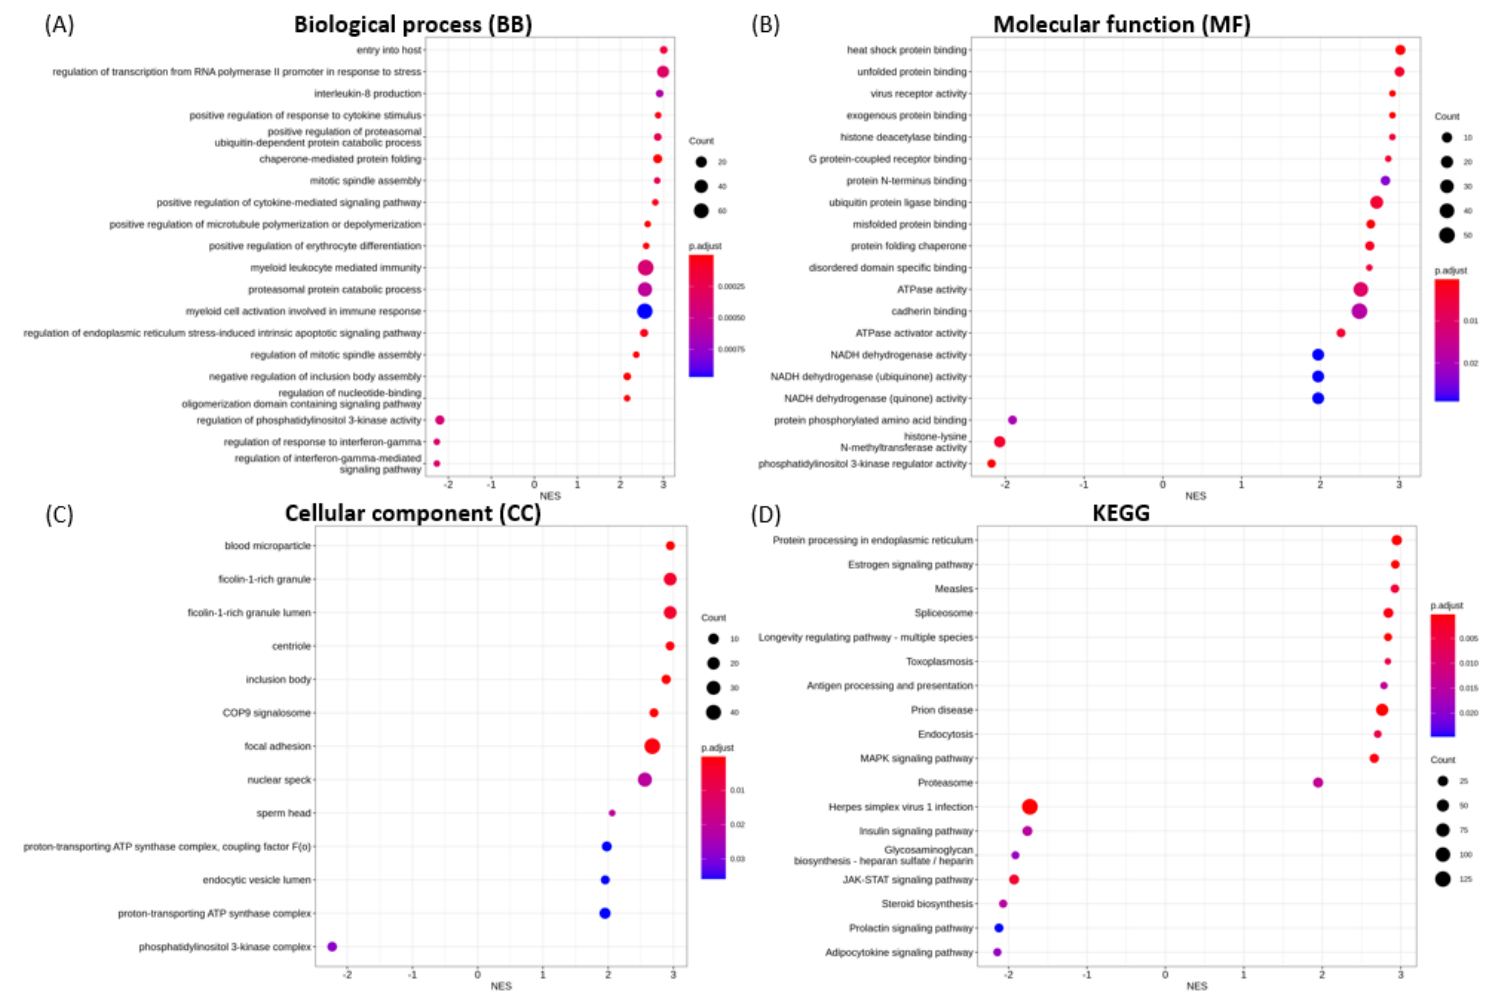
Figure 5. GSEA enrichment for SARS-CoV-2 spike S2 transfection illustrating the top 20 most significantly enriched terms for ( A ) BP, ( B ) MF, ( C ) CC and ( D ) KEGG pathways, in decreasing order based on normalized enrichment score (NES).